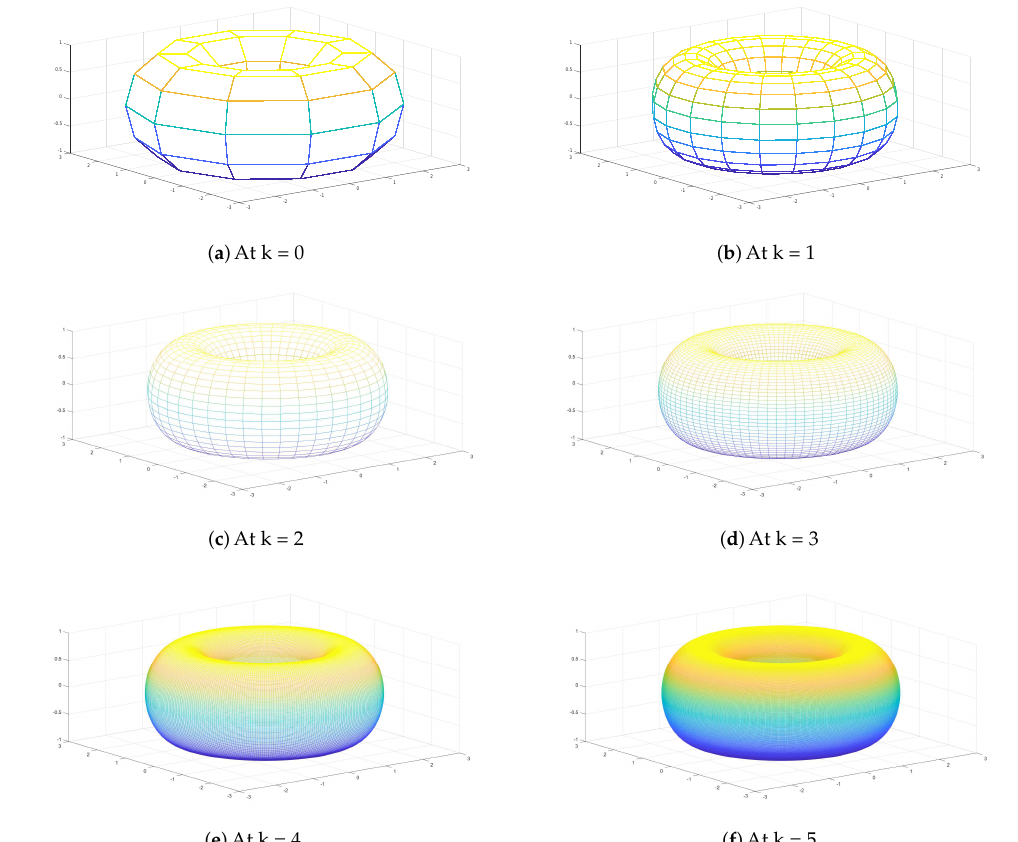
Figure 3. ( a ) The initial polygon; and ( b – f ) the results up to fifth subdivision levels.